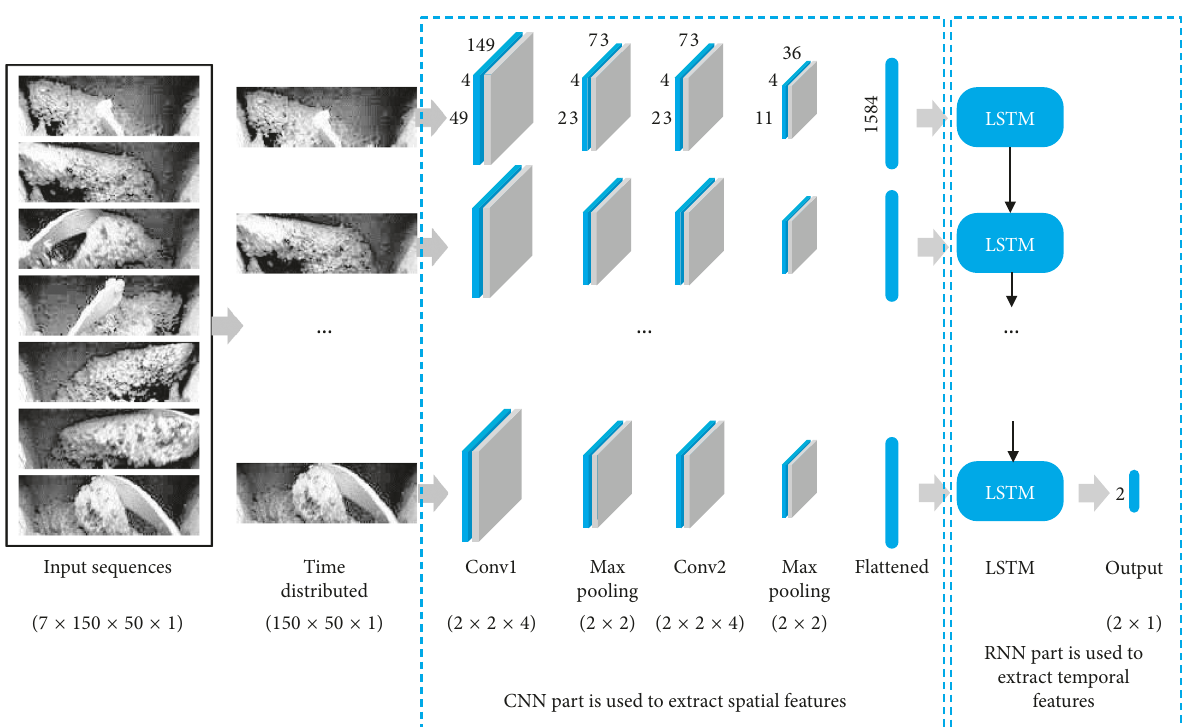
Figure 16: Architecture of the proposed